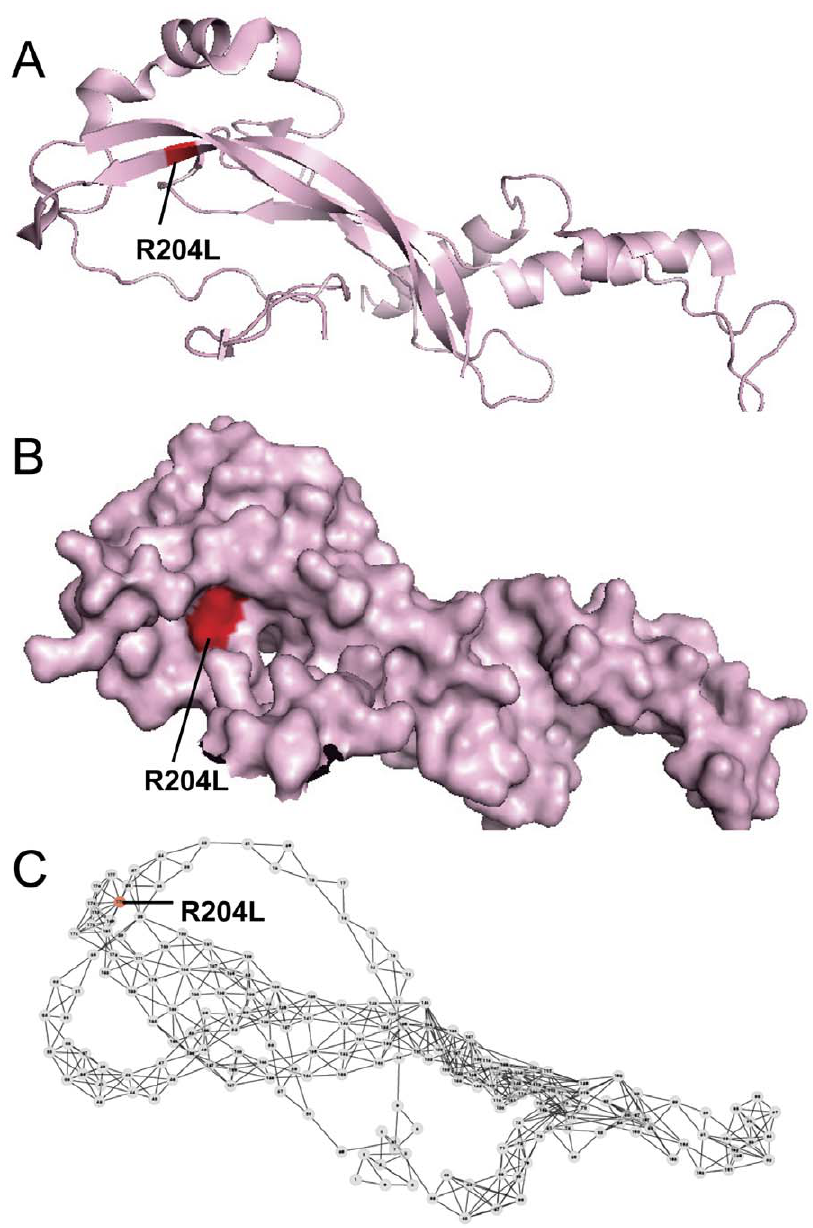
Figure 7. Prediction example of the false negative of the functional effect of SAVs by FunSAV for the Noggin protein. (A) The all- atom; (B) surface; (C) network representations of the Noggin protein. Red color denotes the disease-associated variant. 3D structures were rendered using PyMol [71] and network graphs were drawn using Cytoscape [72].